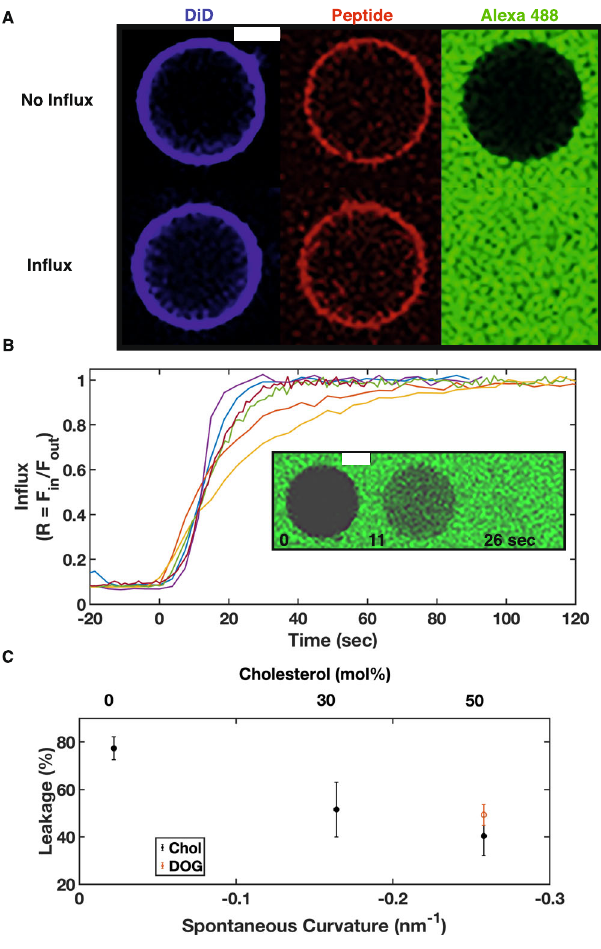
Fig. 1 | In fl uenza fusion peptide induced poration of GUV. A Representative examples of DiD labeled GUV exhibiting binding of the in fl uenza FP and no in fl ux (top) or in fl ux (bottom) of Alexa 488 containing solution following FP addition. B Kineticsofin fl uxfollowingFPaddition.TheratioofAlexa488averageintensities in the GUV lumen and the externalsolution asa function of time. Examples from 6 different experiments. For clarity, differently colored dataare aligned in time such